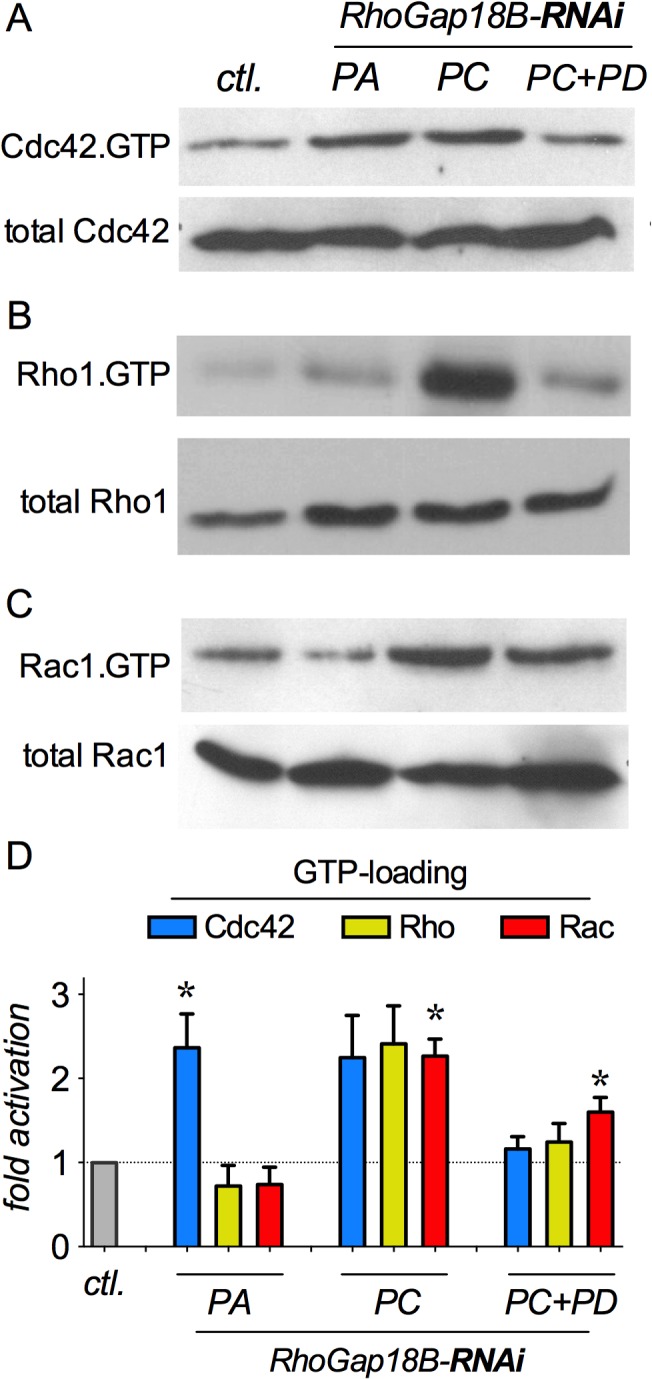
RhoGAP18B isoforms inhibit different members of the Rho-family of GTPases.(A-C) Western blots of GTPase activation experiments. Activated Cdc42 and Rac1 GTPases were pulled down with Pak-PBD, while activated Rho1 was pulled-down by Rhotekin-RBD from S2 cell lysates and then blotted with anti-GTPase antibodies. Incubation of cells with isoform-specific RhoGAP18B RNAi is indicated atop. Representative blots of pull-down assays are shown, and each assay was repeated 5–7 times. (D) Quantitation of active/total GTPase, normalized to untreated S2 cells, suggests specific (PA-Cdc42, and PD-Rac1), as well as general (PC) GTPase activating activities. (One sample t-test with Bonferroni post-hoc comparison vs. control S2 cells; n = 5–7, * p < 0.05; t > 3.4).